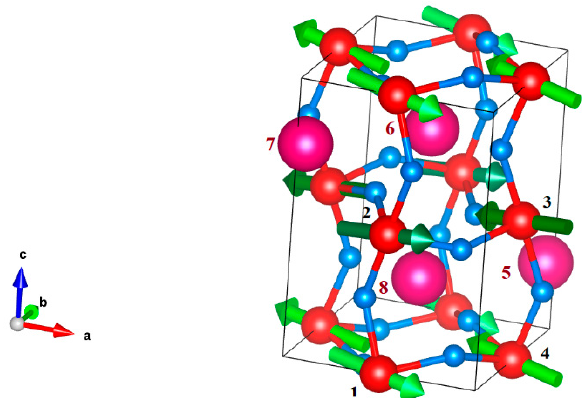
Figure 1. Electric dipole moments arrangement in RCrO 3 unit cell, a, b, c are the principal crystal axes, Cr ions are numbered as 1, 2, 3, 4; R ions are numbered as 5, 6, 7, 8. Green arrows denote the orientation of electric dipole moments in the vicinity of Cr 3+ ions ordered by antiferroelectric D